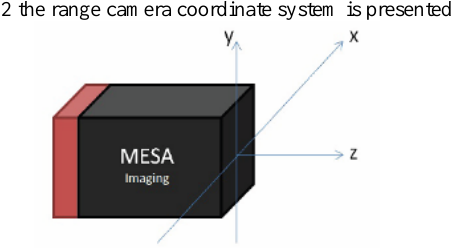
Figure 2. Swiss ranger SR4000 coordinate system